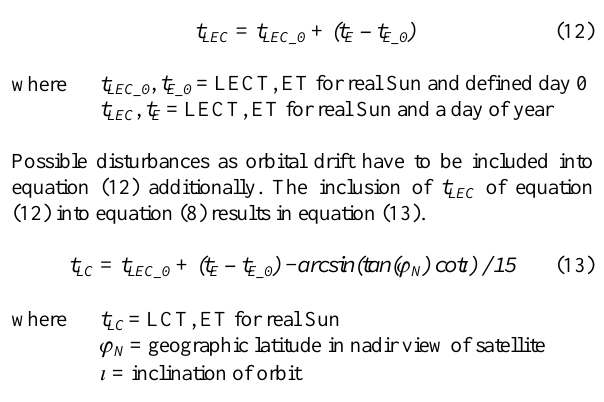
Figure 4. Time offset from LECT of descending node of LANDSAT 7 with an inclination of 98.2 degrees